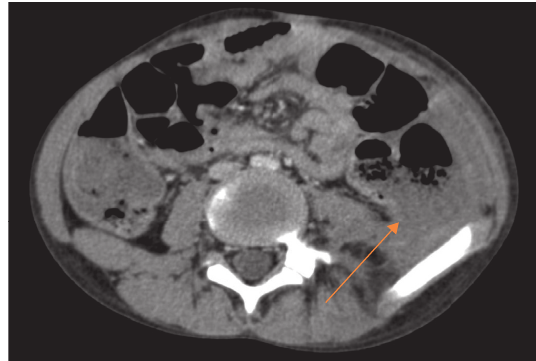
Figure 2: Abdominal CT: solution of continuity of the colonic wall with collection of neighbors